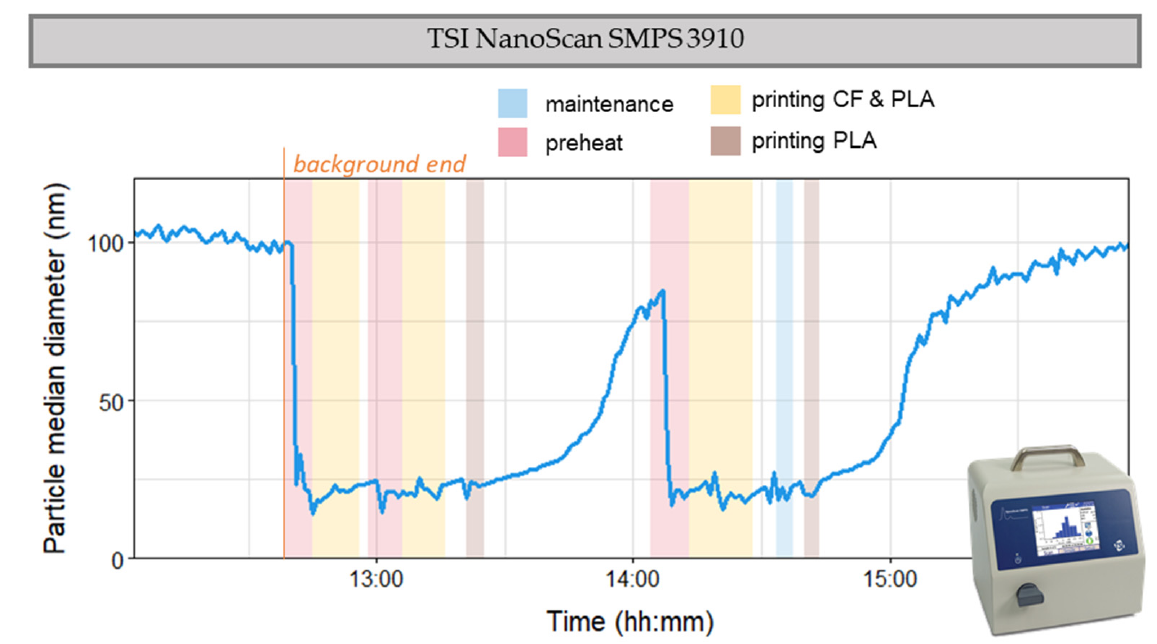
Figure 8. Median particle diameter for Case 4a.